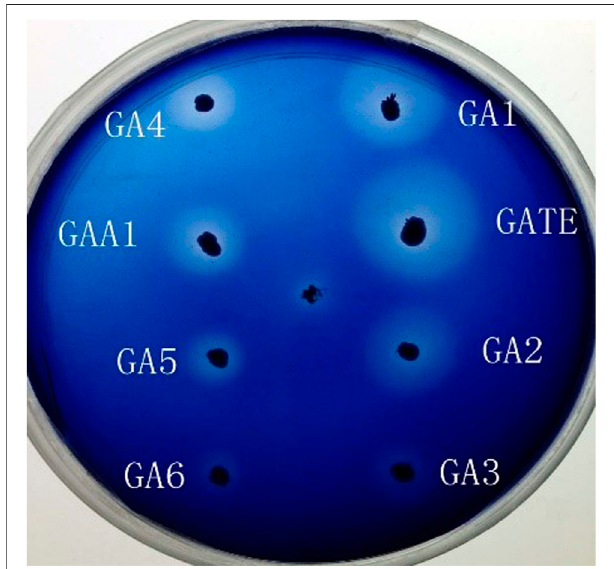
FIGURE 2 | Transparent hydrolysis circle test of the recombinant strains expressing chimeric glucoamylases GAA1, GATE, GA1, GA2, GA3, GA4, GA5, and GA6,